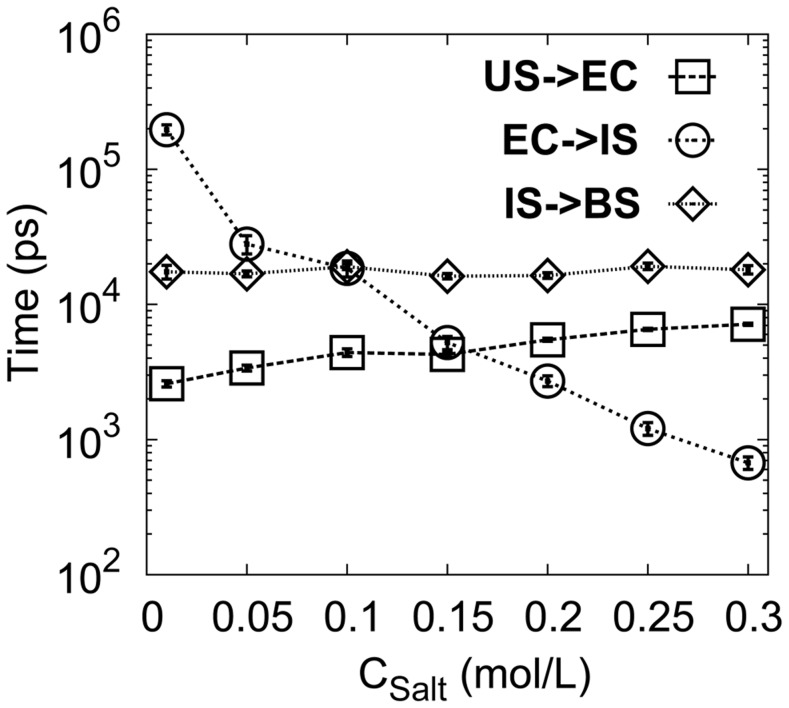
MPT as a function of CSalt.
CSalt is the salt concentration. The error bar represents the standard error of the corresponding MPT.